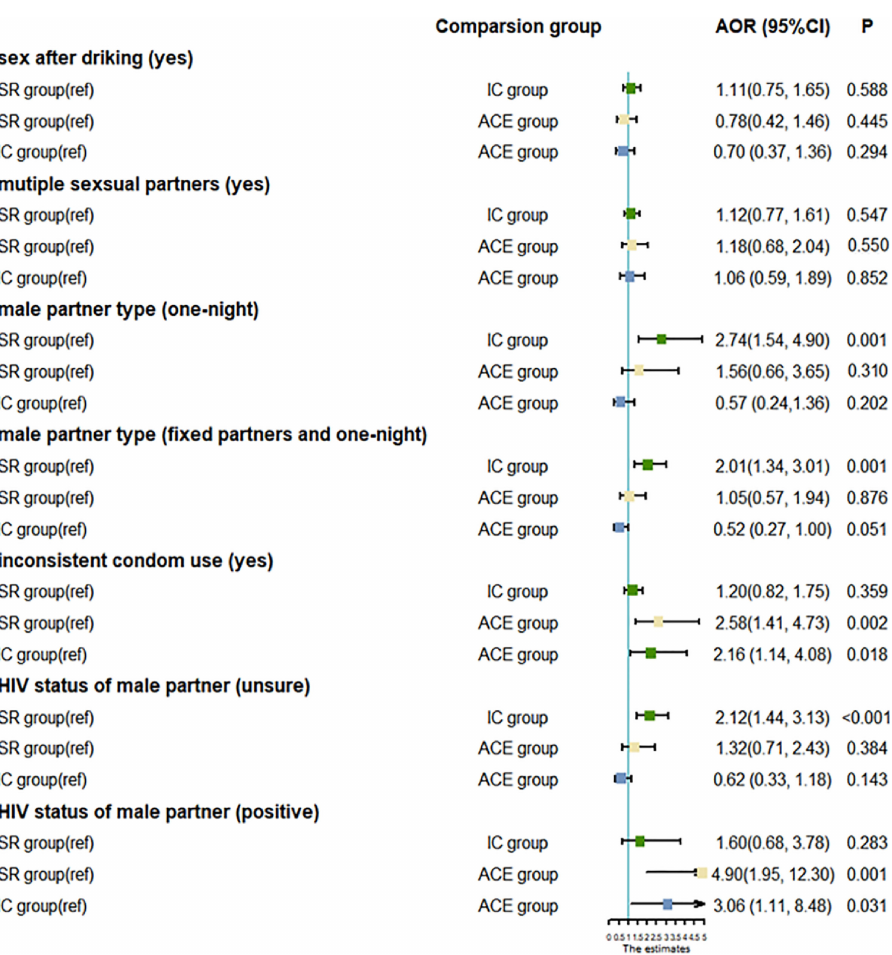
Fig. 2 The association between psychosocial pattern and HIV-related risky sexual behaviors.